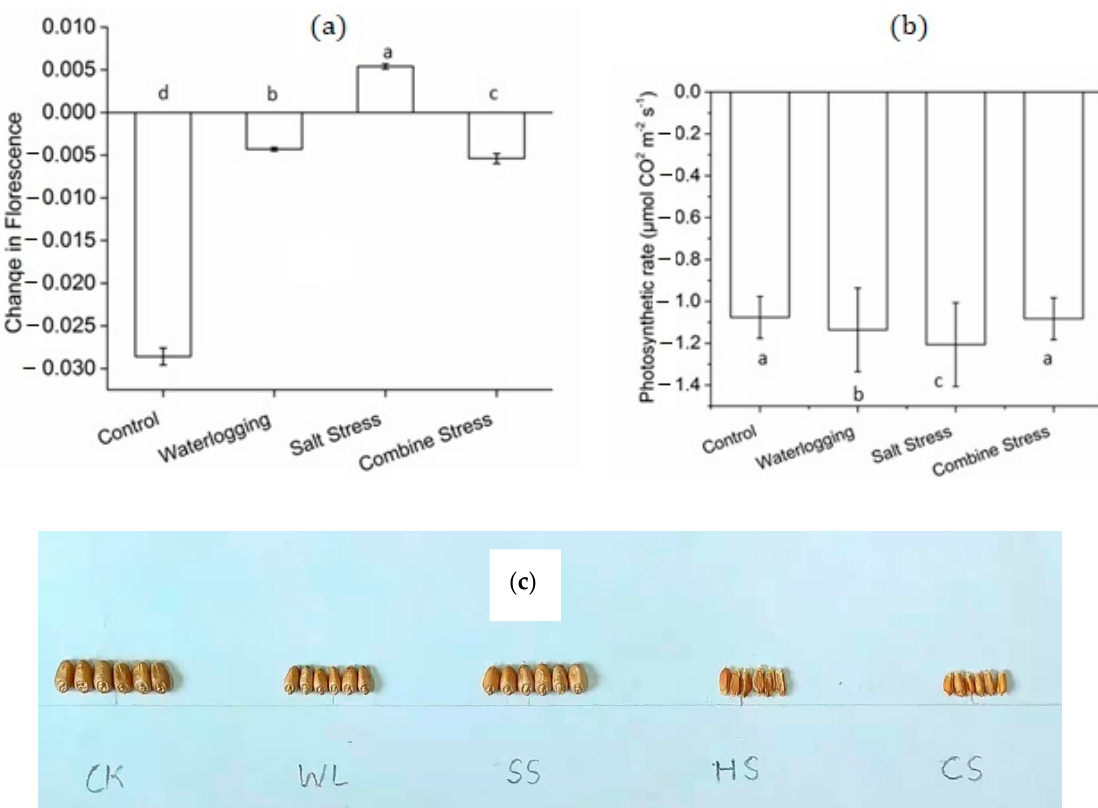
Figure 1. Change in the ( a ) fluorescence and ( b ) photosynthetic activity of the wheat plants from 15 April 2020 to 22 April 2021 (flowering stage) grown under different abiotic stresses. ( c ) The difference in the grain sizes after harvest. Note: reported values are the means and standard deviations of triplicates for each treatment (exact values are given in Table S1). Lowercase letters show the significant differences among treatments according to one-way ANOVA and DMRT, while the significance level was p ≤ 0.05. CK: control; WL: waterlogging; SS: salt stress; HS: heat stress; CS: combined stress.